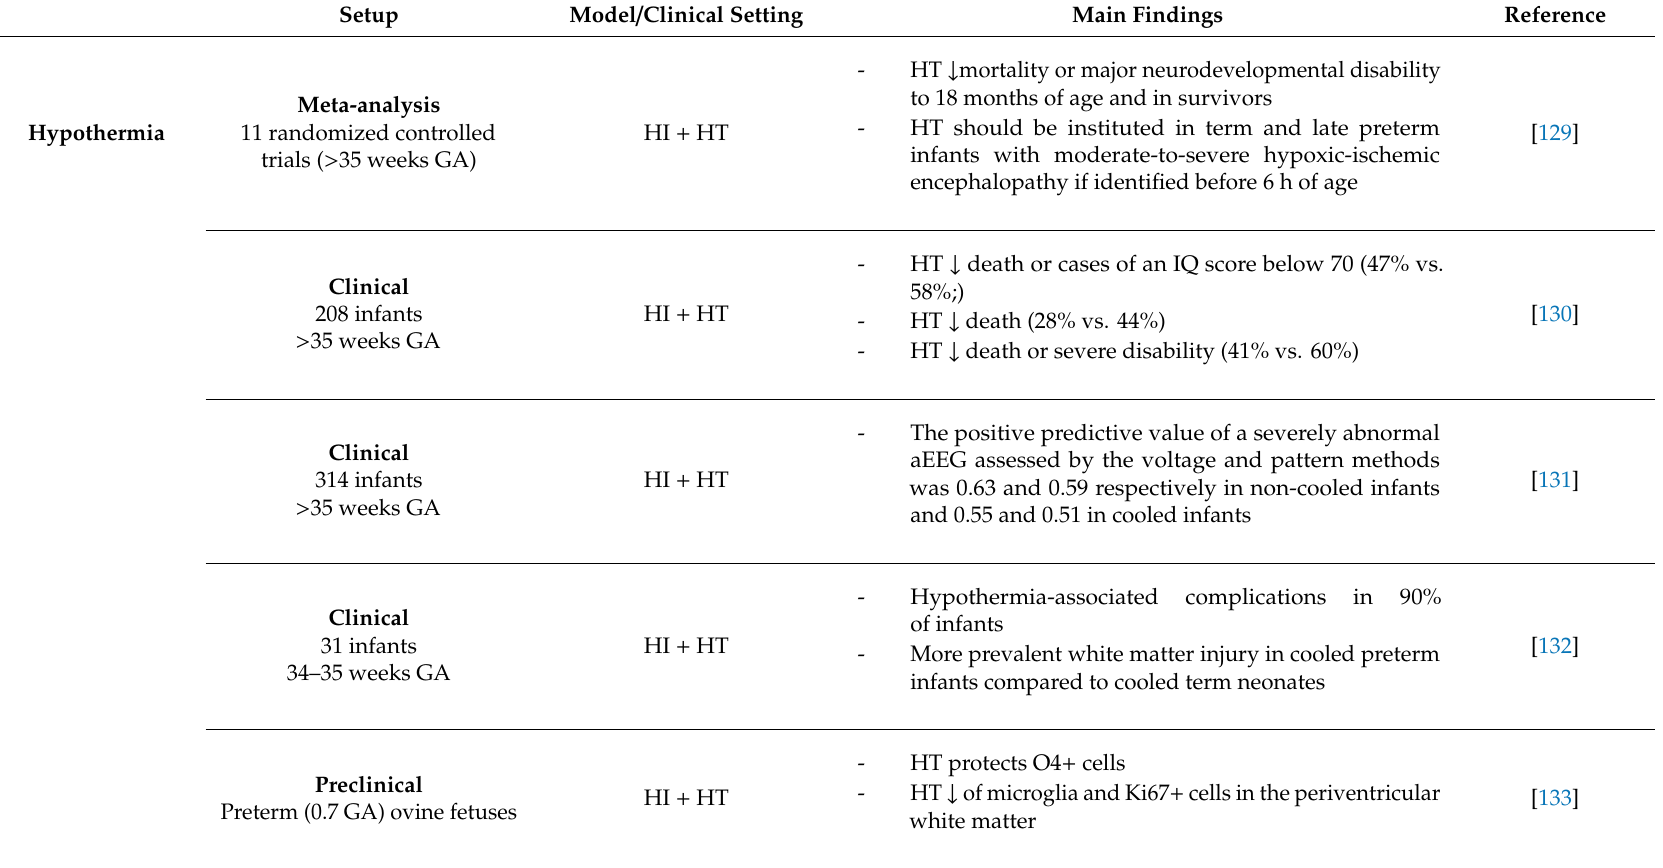
Table 1. Overview of the clinical and preclinical studies for treatment (cell-based, antibodies, drugs) of vulnerable preterm